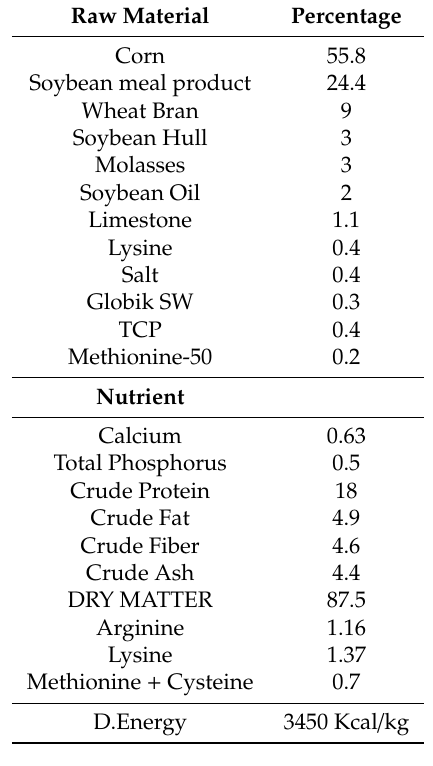
Table 1. Composition of the total mixed ration (TMR) used during the experimental